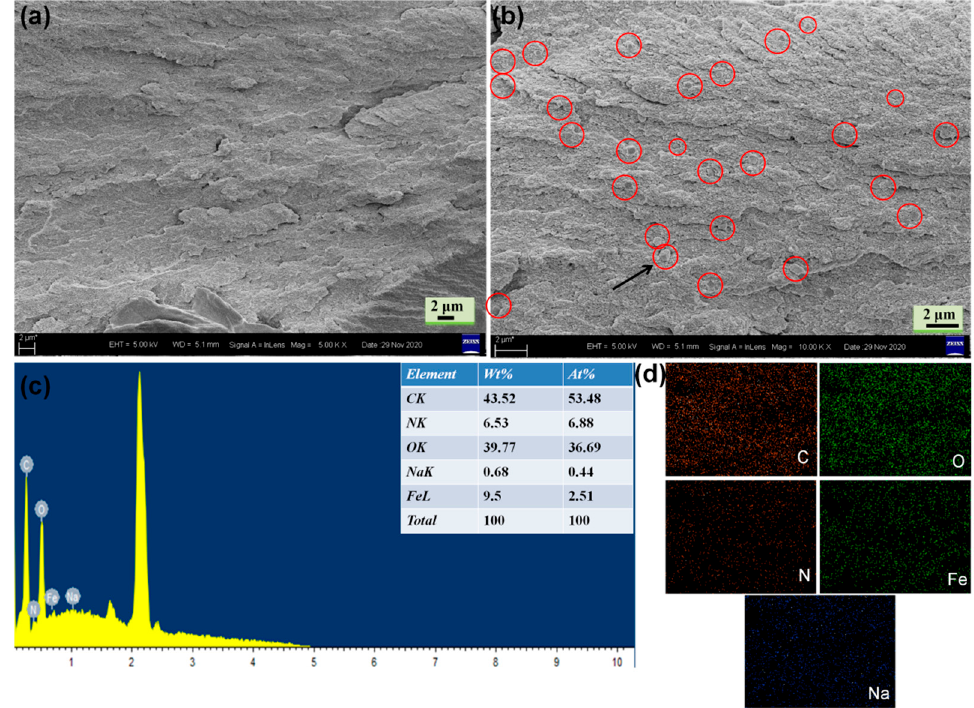
Figure 2. ( a , b ) Cross-sectional SEM images of PCBP-1; ( c ) EDS spectrum of PCBP-1; ( d ) elemental mapping images of PCBP-1 for carbon, oxygen, nitrogen, iron and sodium.